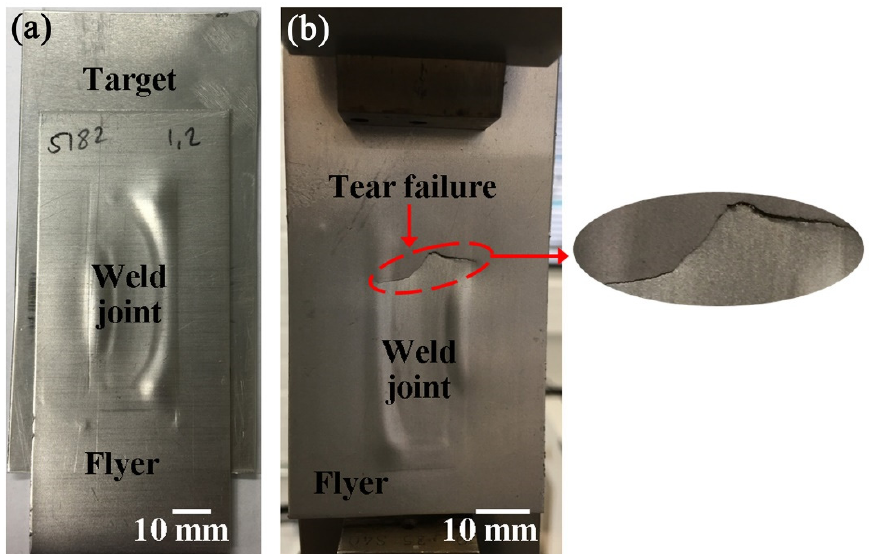
Figure 11. Welded sample obtained with an O-shaped coil ( a ) before and ( b ) after lap shear testing. The fracture near the periphery of the weld, which emerged during lap shear testing, is shown in detail for better clarity. The AA5182 sheet is cracked near the weld. Process conditions: applied discharge energy—13 kJ, standoff distance—2.4 mm, flyer sheet—AA5182, target sheet—DC04 steel.